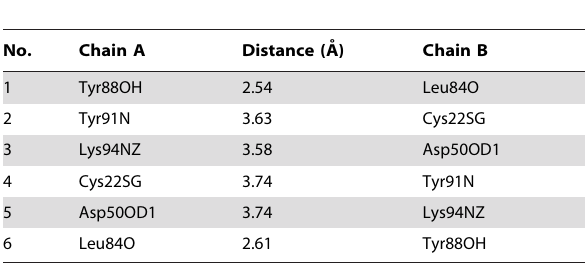
Table 2. Inter monomer hydrogen bonds identified by PISA analysis of the Cthe_2751